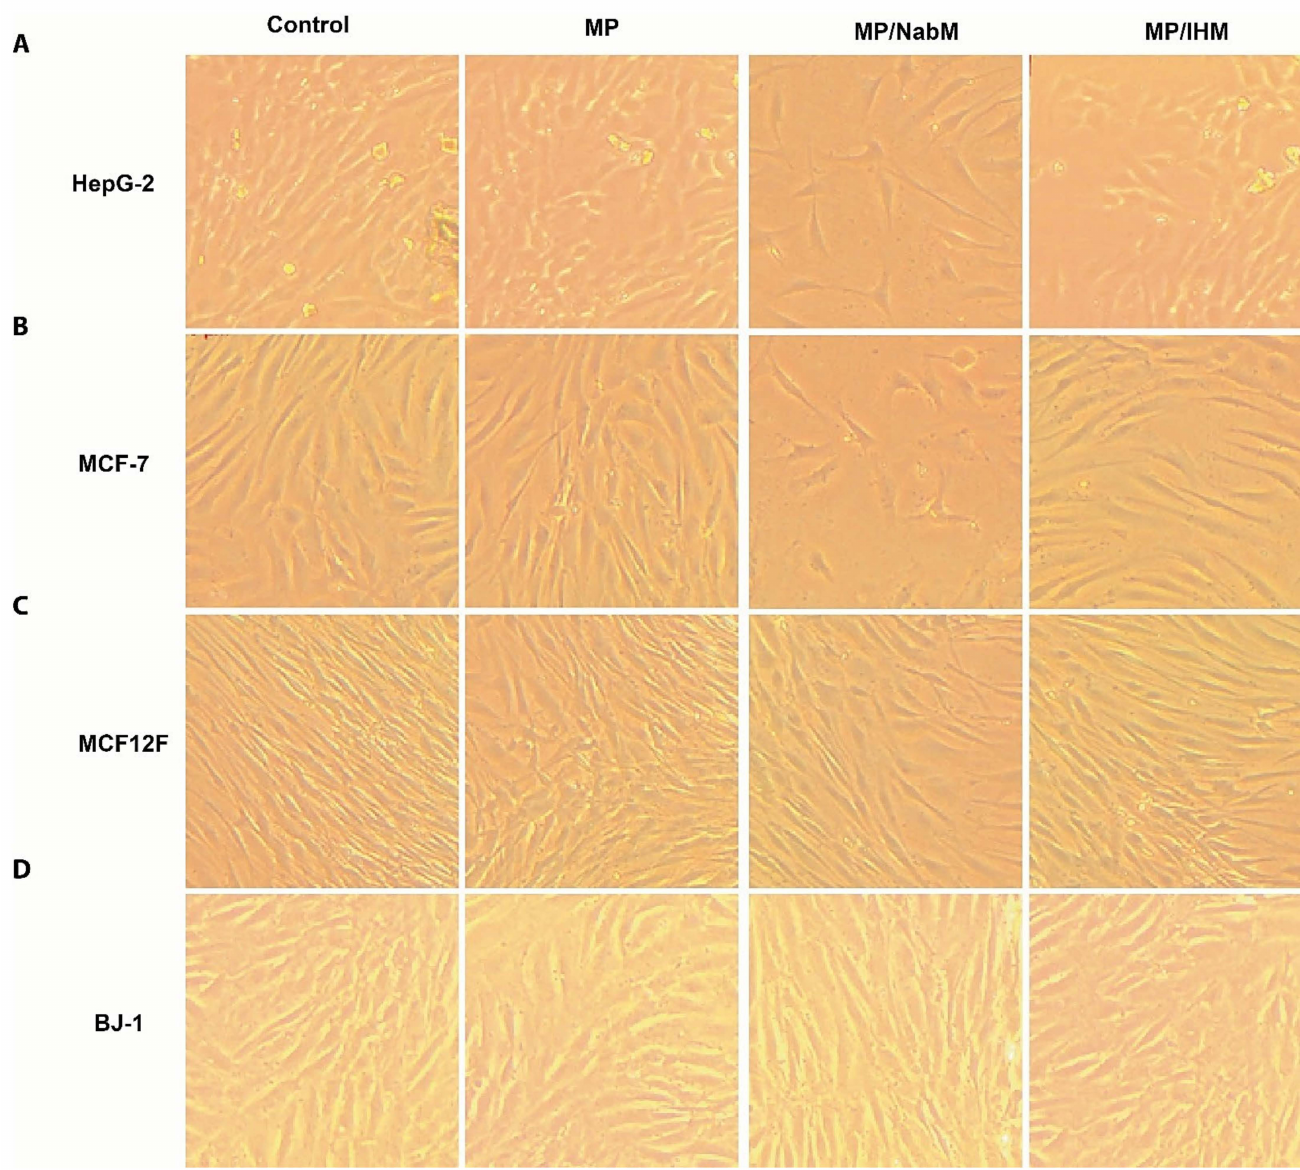
Figure 7. Morphology of human cancer cell lines and normal cell lines; HepG-2 ( A ), MCF-7 ( B ), MCF12F ( C ), and BJ-1 ( D ) before and after treatment with MP and MPMC. MP: milk proteins concentrate; MP/NabM: milk proteins/Nabeq mucilage complex; MP/IHM: milk proteins/Isabgol husk mucilage complex. Table 3. Cancer cytotoxic IC 50 of MP and MPMC on HEPG-2, MCF-7, MCF7-12F, and Bj-1 cells. Cell